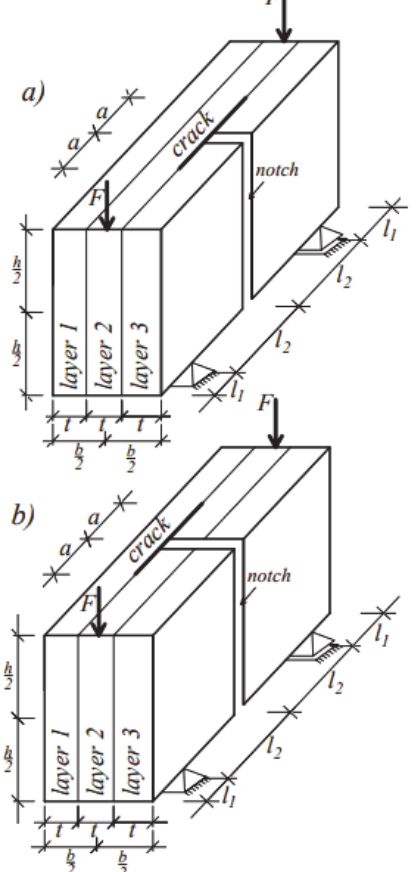
Figure 3: Two three-layered four-point bending beam configurations with delamination crack located between (a) layers 2 and 3 and (b) layers 1 and